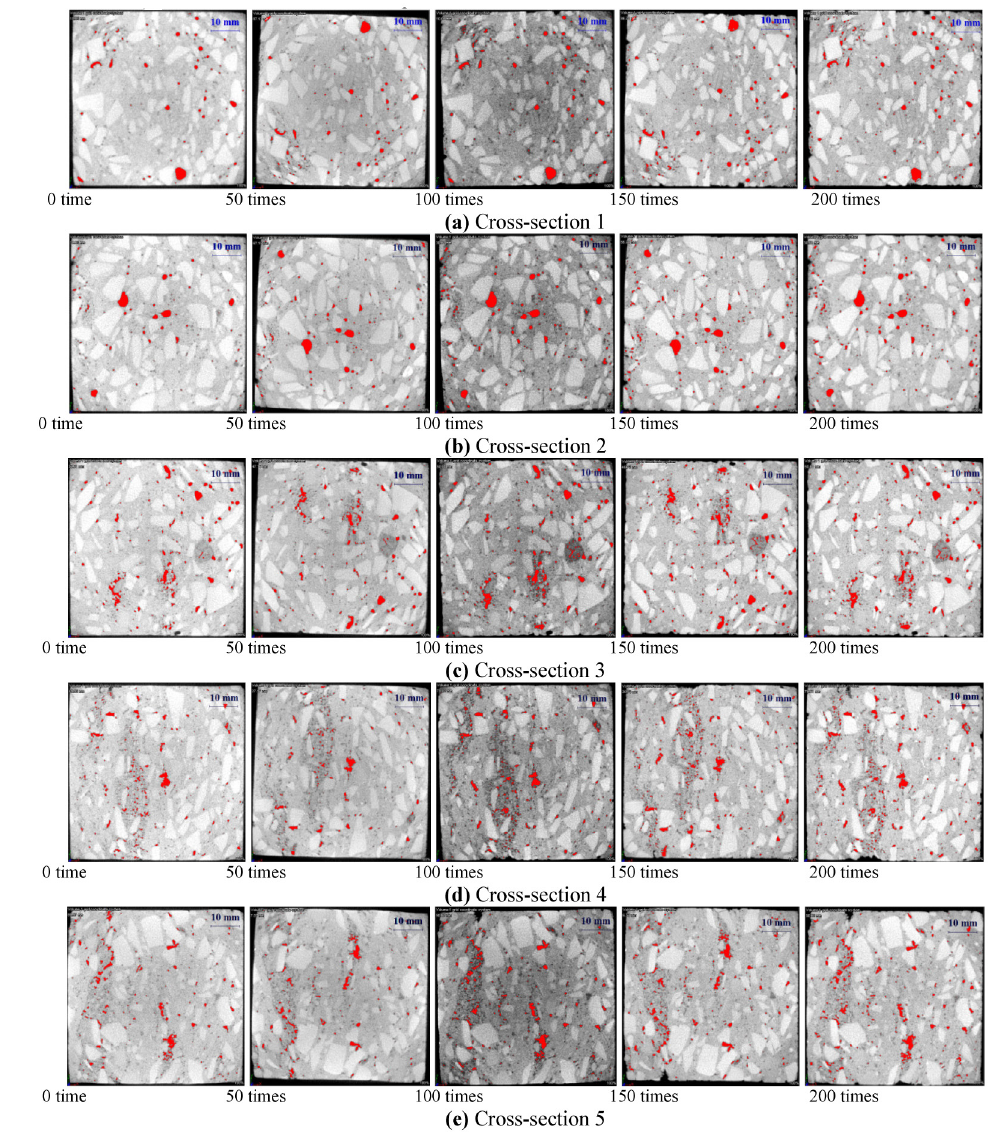
Fig. 12. Changes in the pores of each cross-section in DR2-1 as the number of freeze-thaw cycles